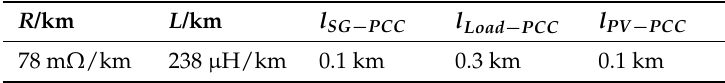
Table 8. Parameters of the transmission